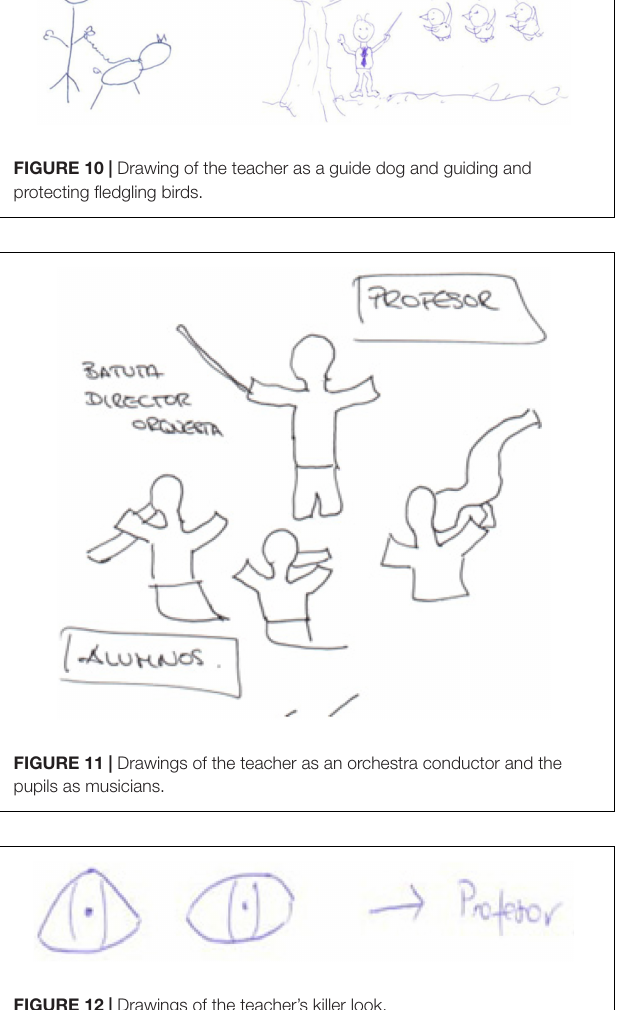
FIGURE 12 | Drawings of the teacher’s killer look.